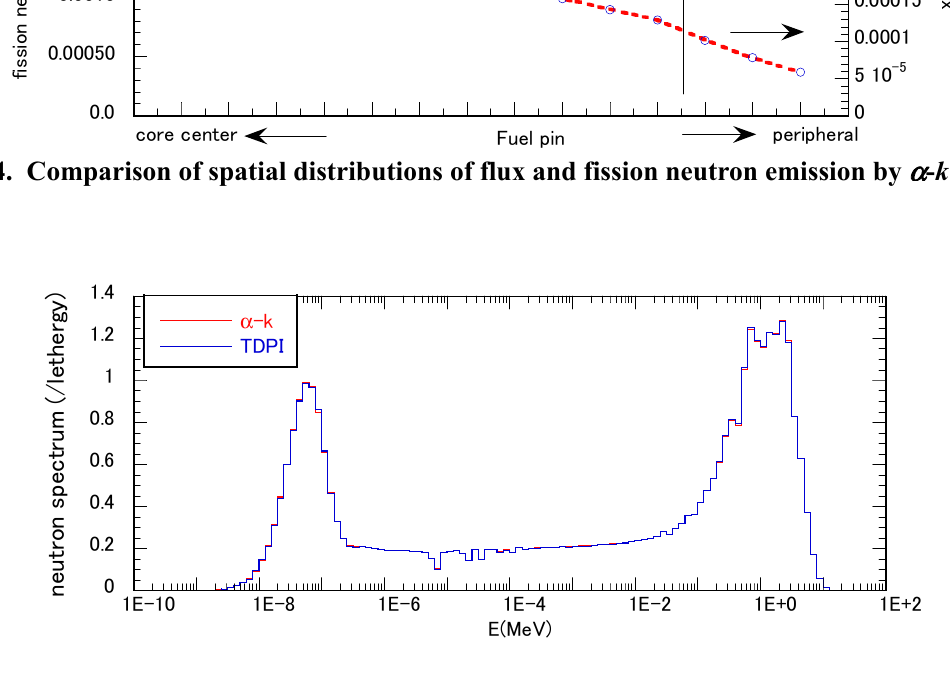
Figure 5. Comparison of core-integrated flux spectra obtained by α - k and